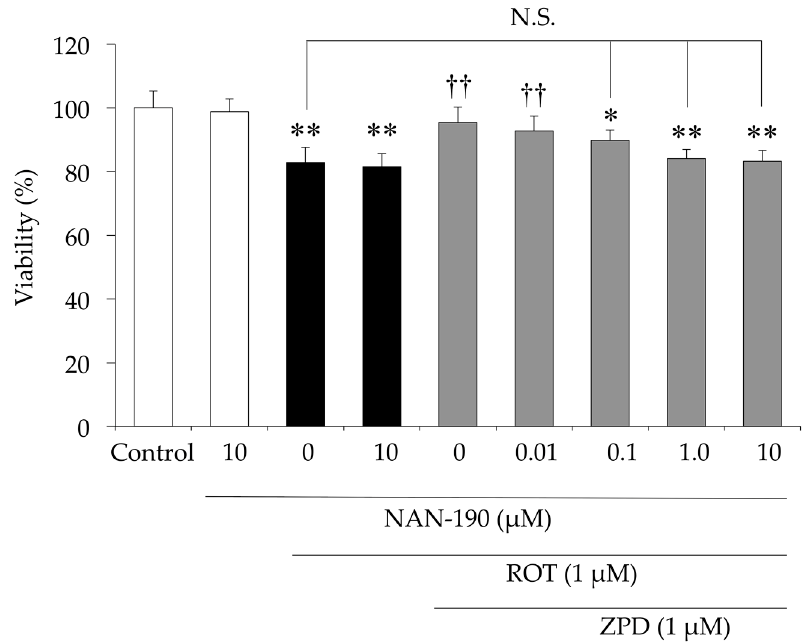
Figure 6. Effect of serotonin 5-HT 1A receptor (5-HT 1A -R) antagonist NAN-190 on the protective effect of ziprasidone (ZPD) against rotenone (ROT)-induced neurotoxicity in PC12 cells. PC12 cells were pre-incubated in the presence or absence of NAN-190 (0–10 µ M) for 2 h. ROT (1 µ M) and ZPD (1 µ M) were added, and the cells were incubated for additional 24 h before CellTiter-Blue assay. Experiments were repeated at least three times, and the values represent the mean of three experiments ± standard deviation (SD). * p < 0.05 versus Control. ** p < 0.01 versus Control. †† p < 0.01, compared to ROT-treated cells. N.S., not significant.